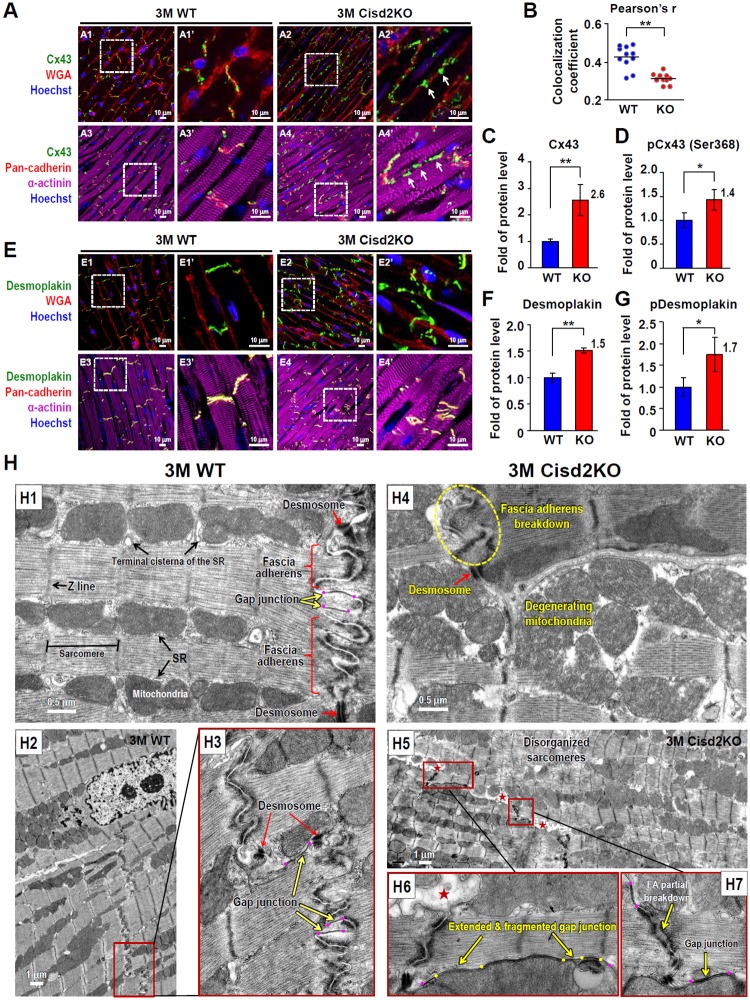
Cisd2 deficiency causes defects in the intercalated disc and leads to ultrastructural abnormalities in the cardiac muscle.(A) Lateralization of gap junctions in the cardiac muscle of Cisd2KO mice. Representative IF images of heart sections stained with antibodies against Cx43 (green) in order to localize gap junctions, against pan-cadherin (red) to localize the intercalated discs, and against α-actinin (purple) to stain muscle fibers. The sections were also stained with Hoechst (blue) to identify nuclei. White arrows indicate lateralization of gap junctions. (B) Colocalization coefficient of gap junction protein (Cx43) and intercalated disc protein (pan-cadherin) was analyzed by Pearson’s correlation. The computed value is presented as the Cx43/pan-cadherin colocalization coefficient. Data were collected from 10 randomly selected fields for each heart sample. There are at least three individual mice in each group. (C and D) Relative protein levels of Cx43 (C) and phosphorylated Cx43 (Ser368) (D) in the hearts of WT and Cisd2KO mice were analyzed by western blotting and then quantified (n = 4). (E) Maldistribution of desmosomes in the cardiac muscle of Cisd2KO mice. Representative IF images of heart sections stained with antibodies against desmoplakin (green), which is localized within desmosomes, with WGA (red) to stain cell membranes by binding to membrane glycoproteins, with antibodies against pan-cadherin (red) to localize the intercalated discs, and with antibodies against α-actinin (purple) to stain muscle fibers. The sections were also stained with Hoechst (blue) to identify nuclei. (F and G) Relative protein levels of desmoplakin (F) and phosphorylated desmoplakin (G) in the hearts of WT and Cisd2KO mice were analyzed by western blotting and then quantified (n = 4). (H) TEM analysis reveals ultrastructural defects in the intercalated discs of Cisd2KO cardiac muscle. Overt ultrastructural abnormalities (namely, shortening and breaking down of the FA; degeneration of the mitochondria, including mitochondria with ruptured outer and inner membranes and swollen mitochondria with fewer crista; and extension and fragmentation of gap junctions) were easily found in the cardiac muscle of Cisd2KO mice at 3M. In H5 and H6, red stars (★) indicate that parts of the space between the two membranes of the intercalated discs are expanded. In H3, H6, and H7, purple dots indicate the two ends of gap junctions. In H6, yellow dots and arrows indicate several degenerating regions with loss of compactness interlaced into an extended gap junction (between two purple dots). Data are presented as mean ± SD and are analyzed by Student t test. *p < 0.05; **p < 0.005. Values for each data point can be found in S1 Data. 3M, 3 months old; Cisd2, CDGSH iron-sulfur domain-containing protein 2; Cx43, Connexin 43; FA, fascia adherens; IF, immunofluorescence; KO, knockout; SR, sarcoplasmic reticulum; TEM, transmission electron microscopy; TG, transgenic; WGA, wheat germ agglutinin; WT, wild type.